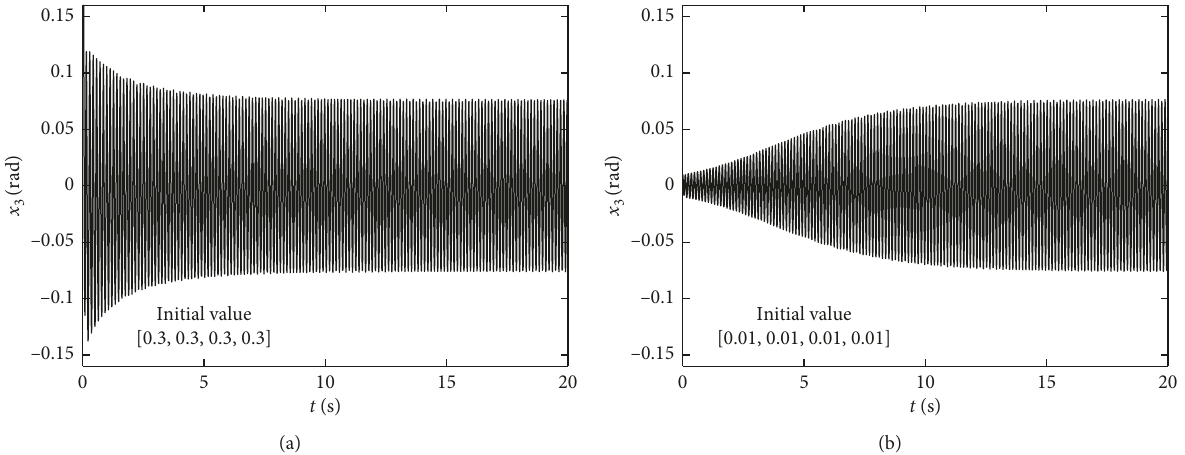
Figure 6: Comparison of amplitudes of the system at different initial values: C � 20.